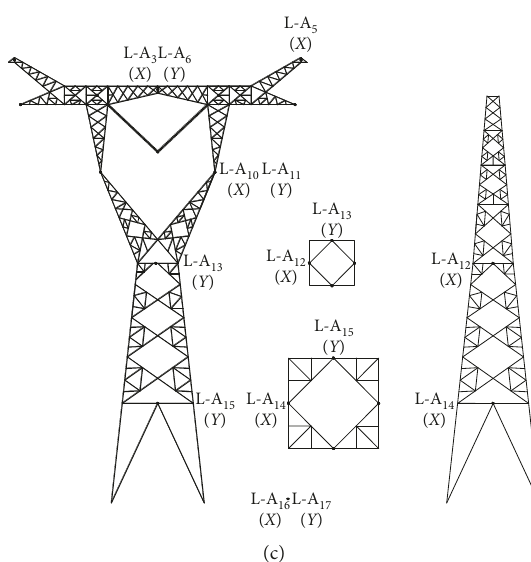
Figure 17: Acceleration sensor placement of the five-tower and four-line model. Layout of the acceleration sensors on (a) the middle tower, (b) the right model tower, and (c) the left model tower.